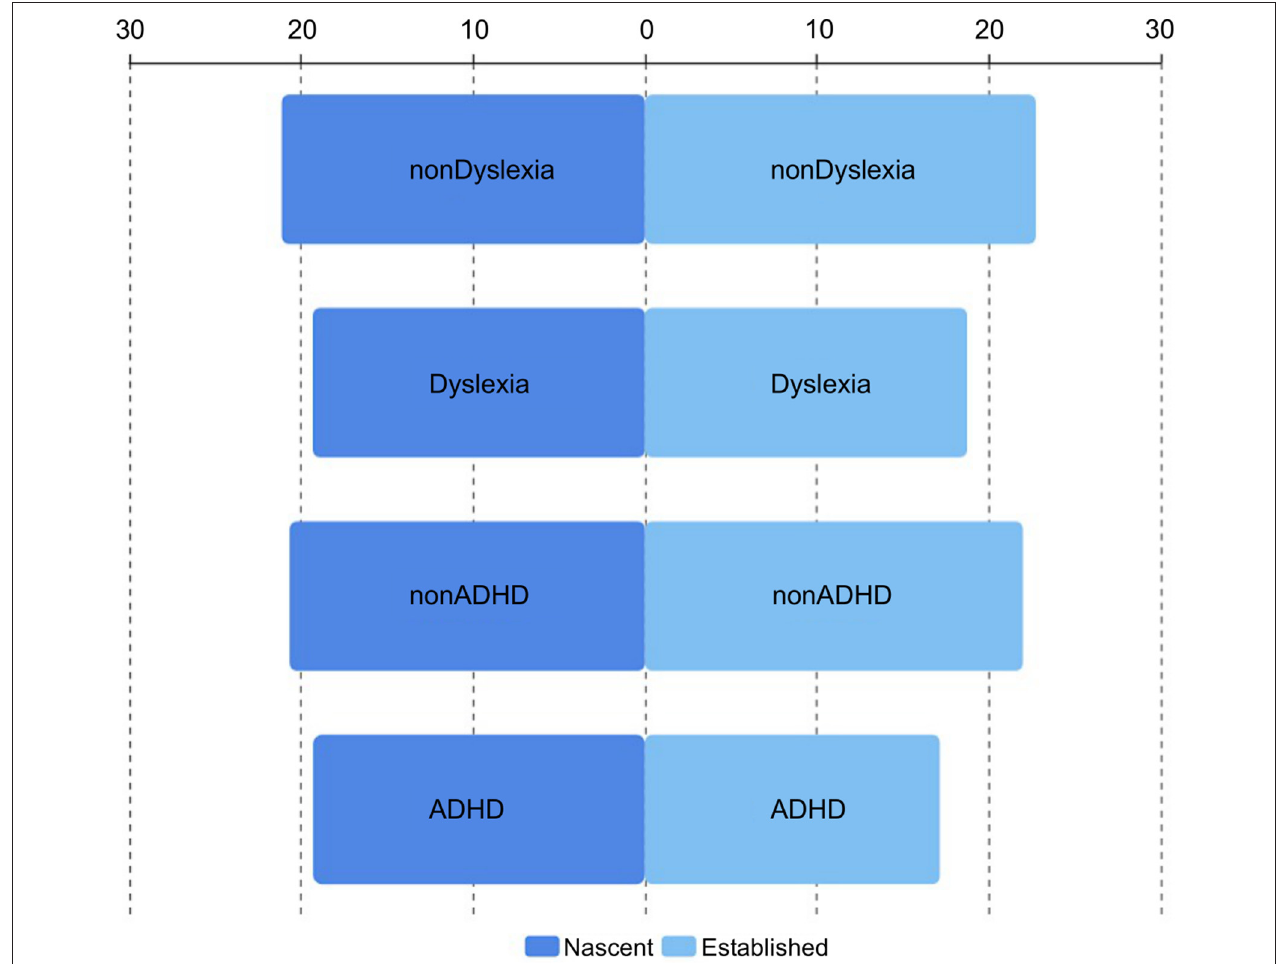
FIGURE 3 | Comparison of wellbeing scores of different entrepreneurs’